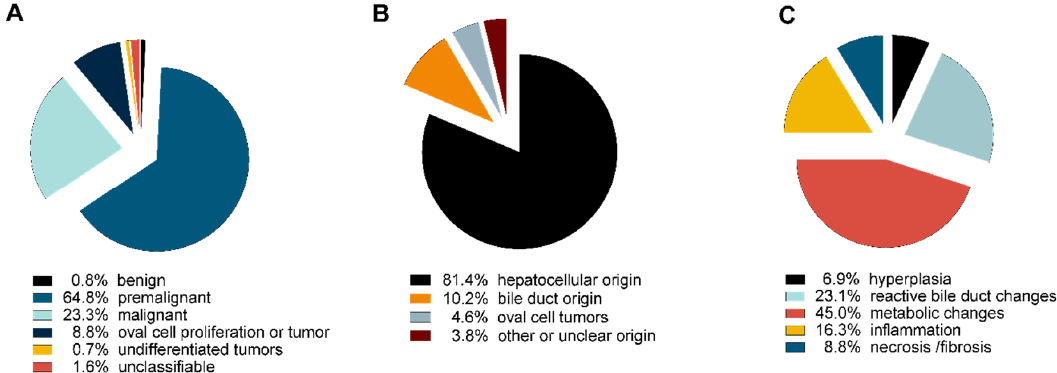
Figure 3. Distribution of observed lesions. ( A ) Distribution of observed lesions; ( B ) histopathological origin of observed neoplastic lesions; ( C ) distribution of non-neoplastic lesions.